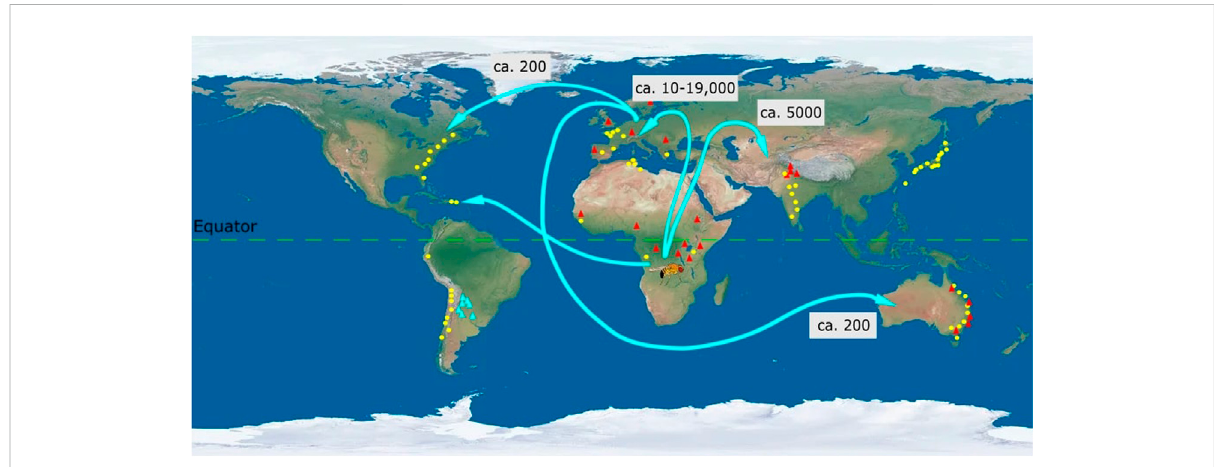
FIGURE 2 Map of the direction of spread and clinal variation of Drosophila melanogaster . Ancestral populations of Drosophila melanogaster from sub- Saharan Africa (Zambia) dispersed to Europe (ca. 10-19,000 years ago) and Asia (ca. 5,000 years ago) (David and Capy 1988; Haudry et al., 2020). From Europe there were subsequent dispersals to Australia and North America [ < 200 years ago (Keller, 2007)]. Population recently dispersed from Africa to North America and this dispersal is considered to be mediated through human movement. Clinal variation in D. melanogaster across latitudes and altitudes has been denoted by yellow circles and red triangles, respectively. Each circle or triangle represents particular geographic locations (not to scale) from which populations were collected. Latitudinal and altitudinal clines have been observed for D. melanogaster in Africa, Europe, Asia, and Australia. In North and South America only latitudinal clines are known for D. melanogaster and no clines are known across altitudes. Instead D. buzzati (blue) exhibits an altitudinal cline (thermal tolerance) in South America (Sørensen et al., 2005). Numbers in boxes represent the approximate time in years when D. melanogaster dispersed throughout the world from the ancestral population in Africa. Latitudinal clines havebeendepictedfor desiccationtolerance (Asia:India(Karanetal.,1998)), chromosomal inversion(Asia:Japan(InoueandWatanabe1979)) and wing area (Australia, (James et al., 1995)), (South America, (Land et al., 1999)). Altitudinal clines have been depicted for body pigmentation (Asia (Parkash and Munjal, 1999)), diapause incidence (North America (Schmidt and Conde 2006)) and cold tolerance (Australia, (Collinge et al., 2006)). Latitudinal and altitudinal clines for wing area mirror each other in Europe and Africa (Klepsatel et al., 2014). All traits depicted exhibit positive clinal variation.Thus,wingareaislargerforpopulationsathigherlatitudesandaltitudescomparedtopopulationsatlowerlatitudesandaltitudes(Klepsatel et al.,